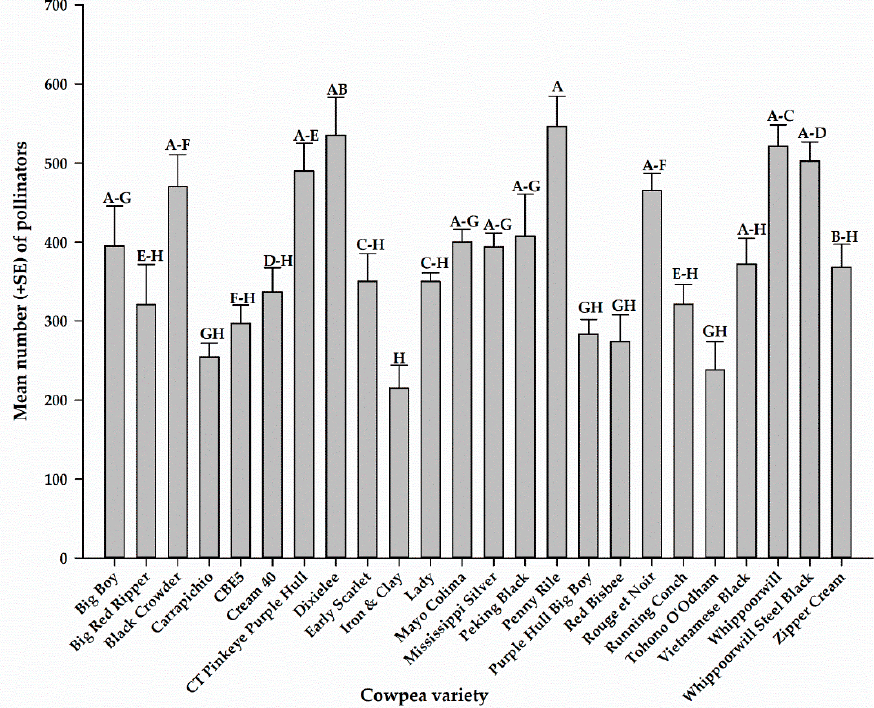
Figure 6. Mean number of all pollinators captured on each variety for the entire sampling period. Mean numbers followed by the same letters are not significantly different ( p > 0.05).